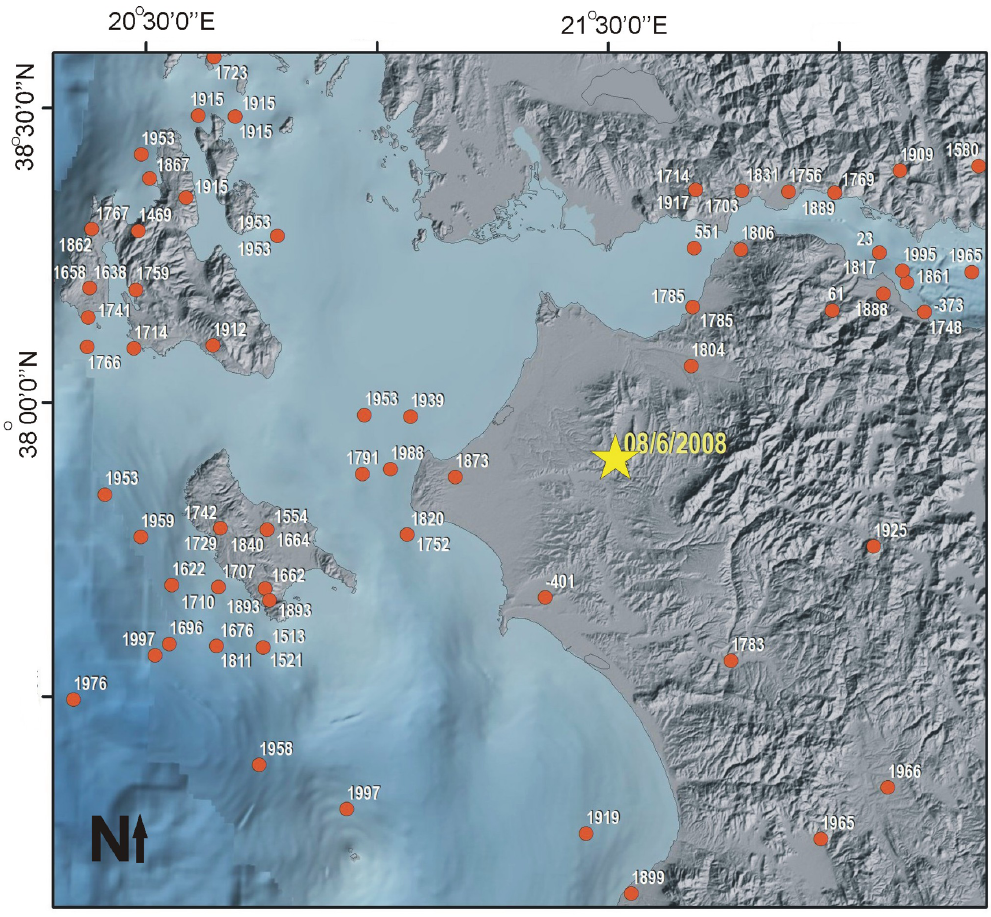
Figure 2. Map showing the distribution of earthquake’s epicenters (for the period 1911-2007; M>5.5) in the broader area (red circles) and the location of June 8, 2008, earthquake epicenter (yellow